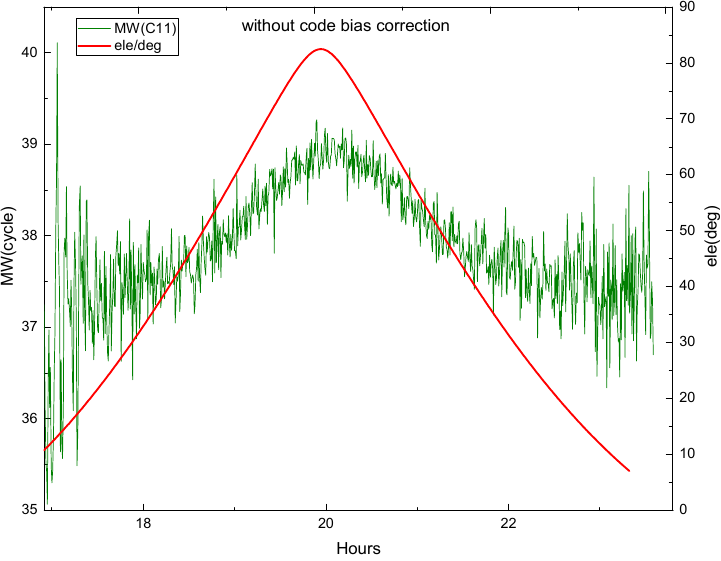
Figure 5. The M-W variation of C11 at XMIS, on DOY 083, 2018.